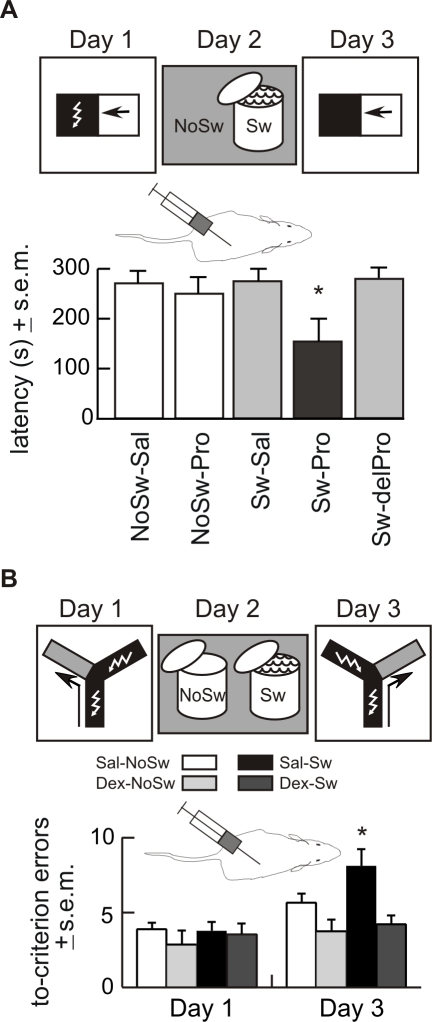
Experiments 5 and 6—Stress is necessary for the forced swim to alter consolidated memories.(A) Experiment 5—Propranolol caused amnesia of inhibitory avoidance memory only if it was administered after the forced swim. Rats were trained in the inhibitory avoidance paradigm on Day 1. On Day 2, they were either forced to swim (Sw) or just handled (NoSw), and immediately afterwards injected with 10 mg/ml/kg Propranolol or saline (NoSw-Sal n = 11, NoSw-Pro n = 10, Sw-Sal n = 10, Sw-Pro n = 11). Rats in the Sw-delPro group (n = 12) were injected with Propranolol 5 h after the swim. The average ± step-through latencies on Day 1 were: NoSw-Sal = 8.5±1.7; NoSw-Pro = 6.5±0.79; Sw-Sal = 7.4±1.5; Sw-Pro = 5.5±0.91; Sw-delPro = 7.9±0.98). The step-through latencies recorded on Day 3 are plotted. The groups did not differ on Day 1, but they differed on Day 3 (F4,49 = 3.0; p = 0.03). Amnesia, manifested as reduced step-through latencies, was observed only in the Sw-Pro group (all post hoc ps <0.05) (* p<0.05). The data indicate the swim activated the consolidated memory. Whether or not inhibitory avoidance was enhanced by the swim could not be determined in this experiment because performance was already maximal after the single conditioning trial. The data cannot be explained by previous work showing that exposure to a novel alerting stimulus can enhance retrieval of conditioned inhibitory avoidance because in that case, beta-endorphin activation triggered beta-noradrenergic and cholinergic processes that acted at the time of retrieval only if the retrieval test was given within less than 6 h [63],[64]. (B) Experiment 6—Dexamethasone blocks the swim-induced enhancement of memory. Rats were trained in the intensive left/right discrimination on Day 1. The next day, Dexamethasone (Dex; 0.2 mg/kg i.p.) or saline (Sal) was administered 2 h prior to the forced swim (Sw) or no swim (NoSw) shallow-water control treatments. Retention of the Day 1 left/right discrimination memory was tested on Day 3 by the reversal test. Enhanced memory was observed in the saline-treated animals that were forced to swim (Sal-Sw), but the effect was blocked by the action of Dexamethasone in the (Dex-Sw) group. (* p<0.05 compared to the saline-treated no swim (Sal-NoSw) control group).